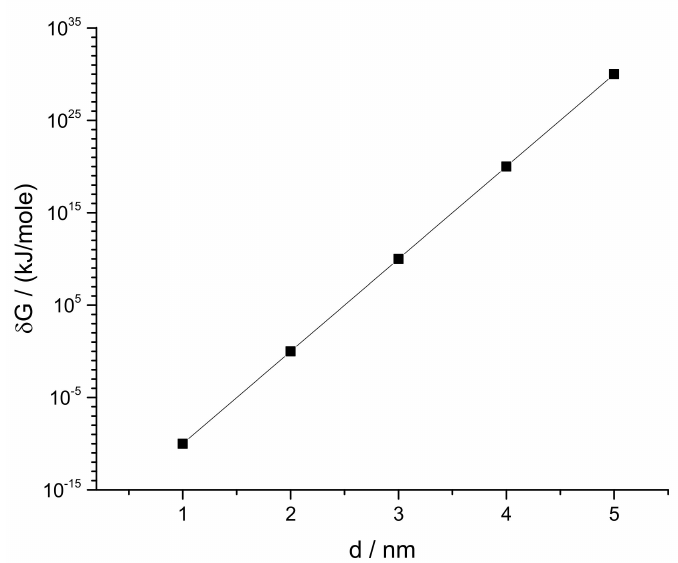
Figure 12. Energy in kJ/mole for inter particle distance, following ad hoc assumptions (see Materials and Methods: NCs considering relevant physiological parameters) [8]. Values of δ G is found in order detected in MD simulations for a drug–lipid pair interaction where d ≤ 2 nm [2].